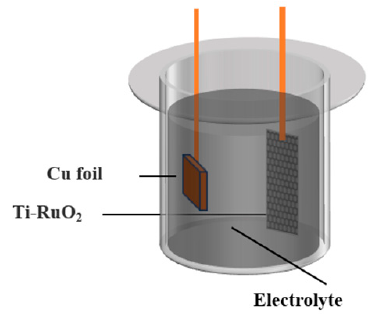
Figure 1. Schematic diagram of electrodeposition